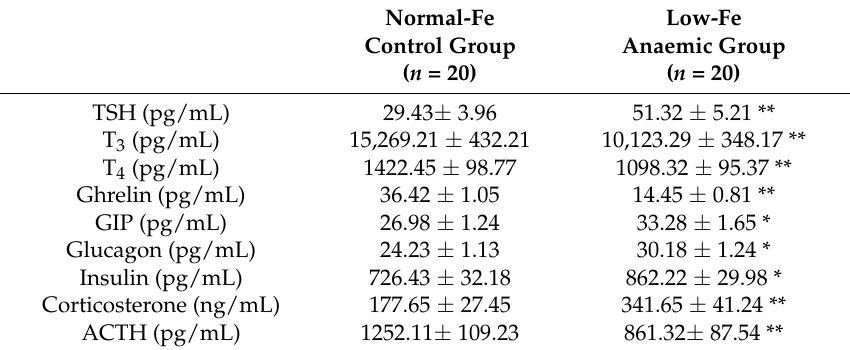
Table 6. Plasma concentration of hormones affecting the basal metabolic